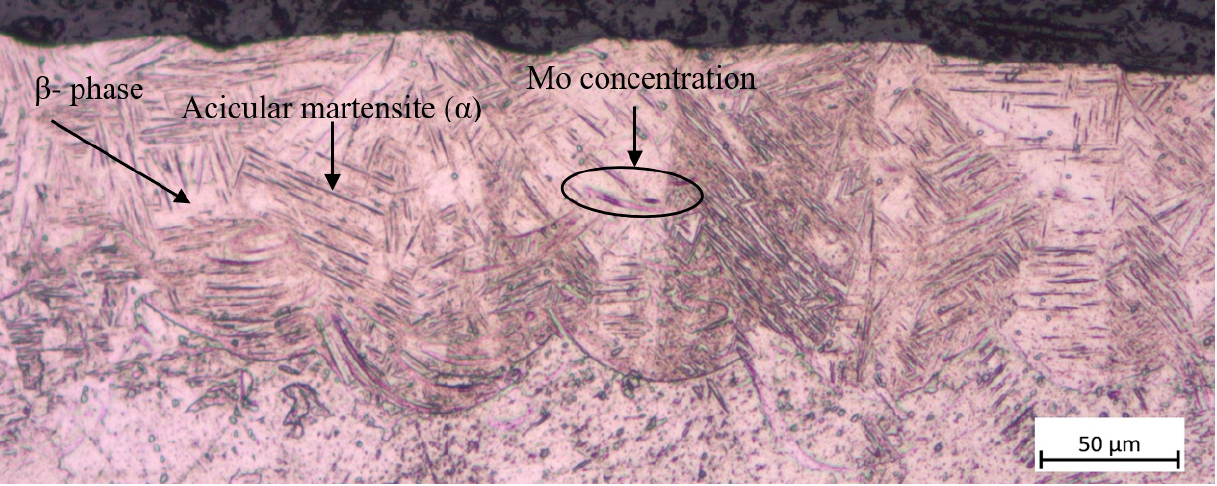
Figure 11. Ti5Mo